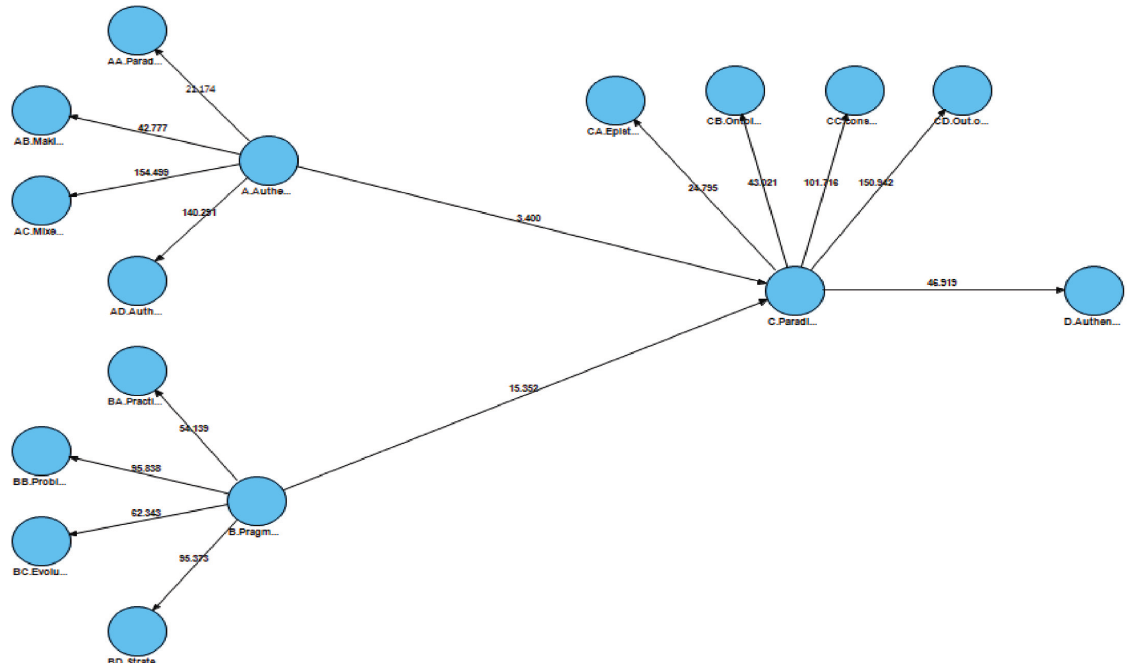
Figure 7: The internal model of first-order assumptions in general significance